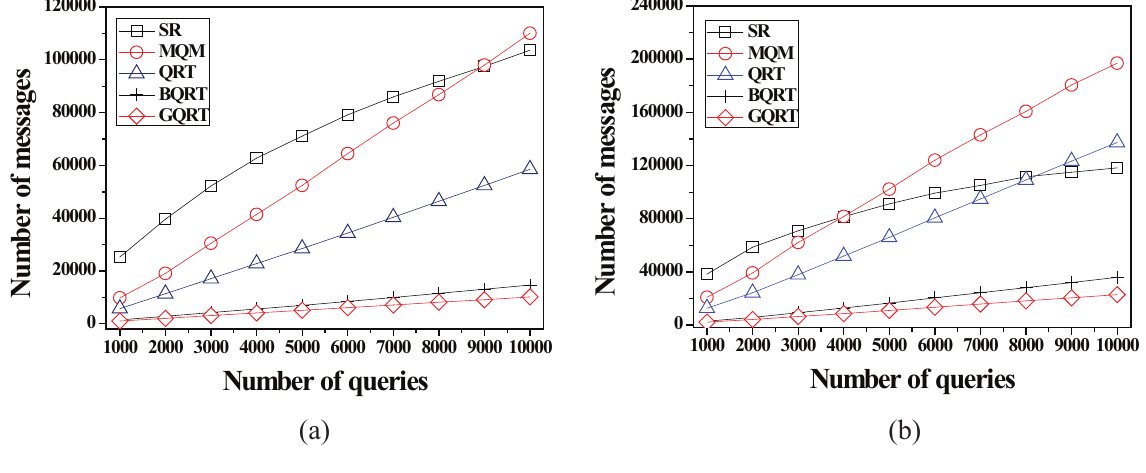
Figure 9. Total number of messages vs . cardinalities of Uniform and Skewed . ( a ) Uniform ; ( b ) Skewed